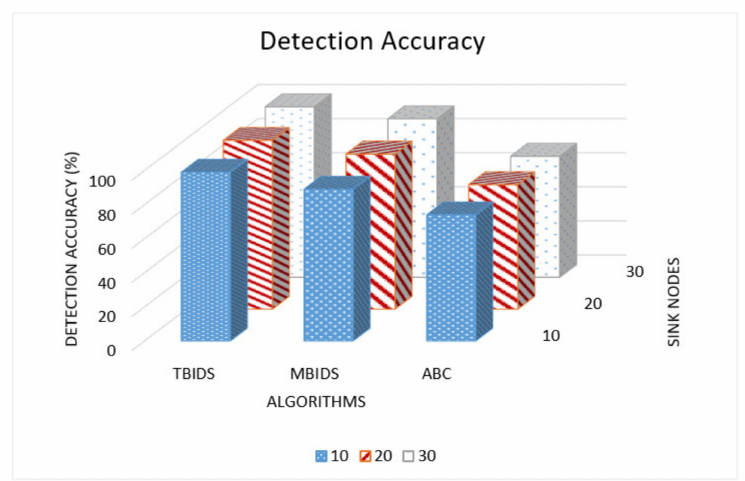
Figure 11. Detection accuracy for the large-scale network (8000 nodes) with 10, 20, and 30 sink nodes.